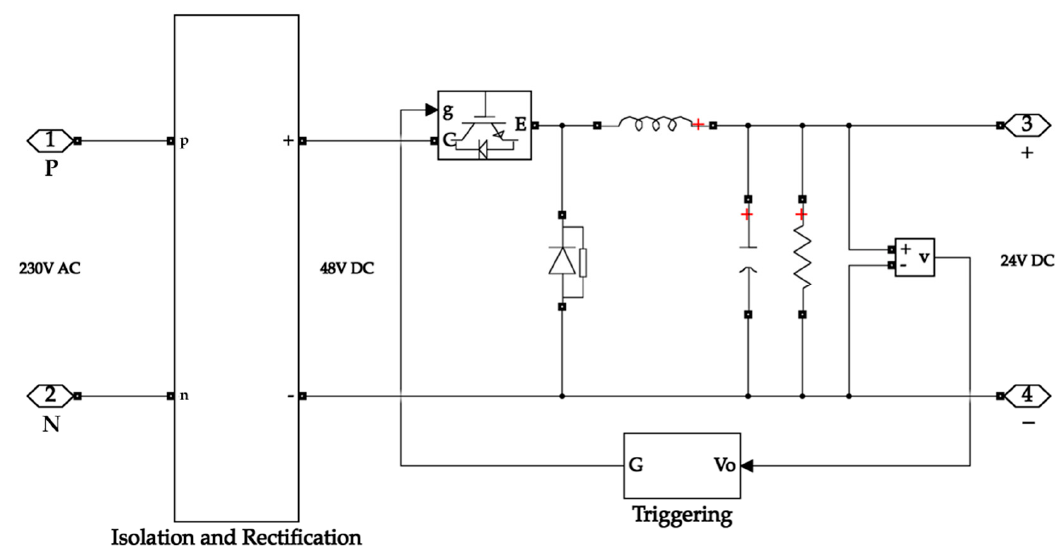
Figure 6. Buck converter with rectification on the input side of the system.